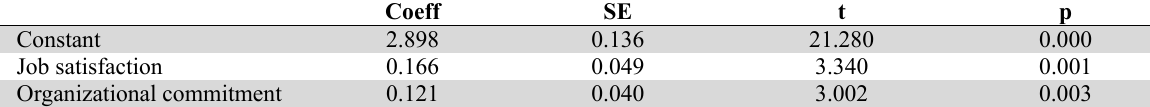
Job performance